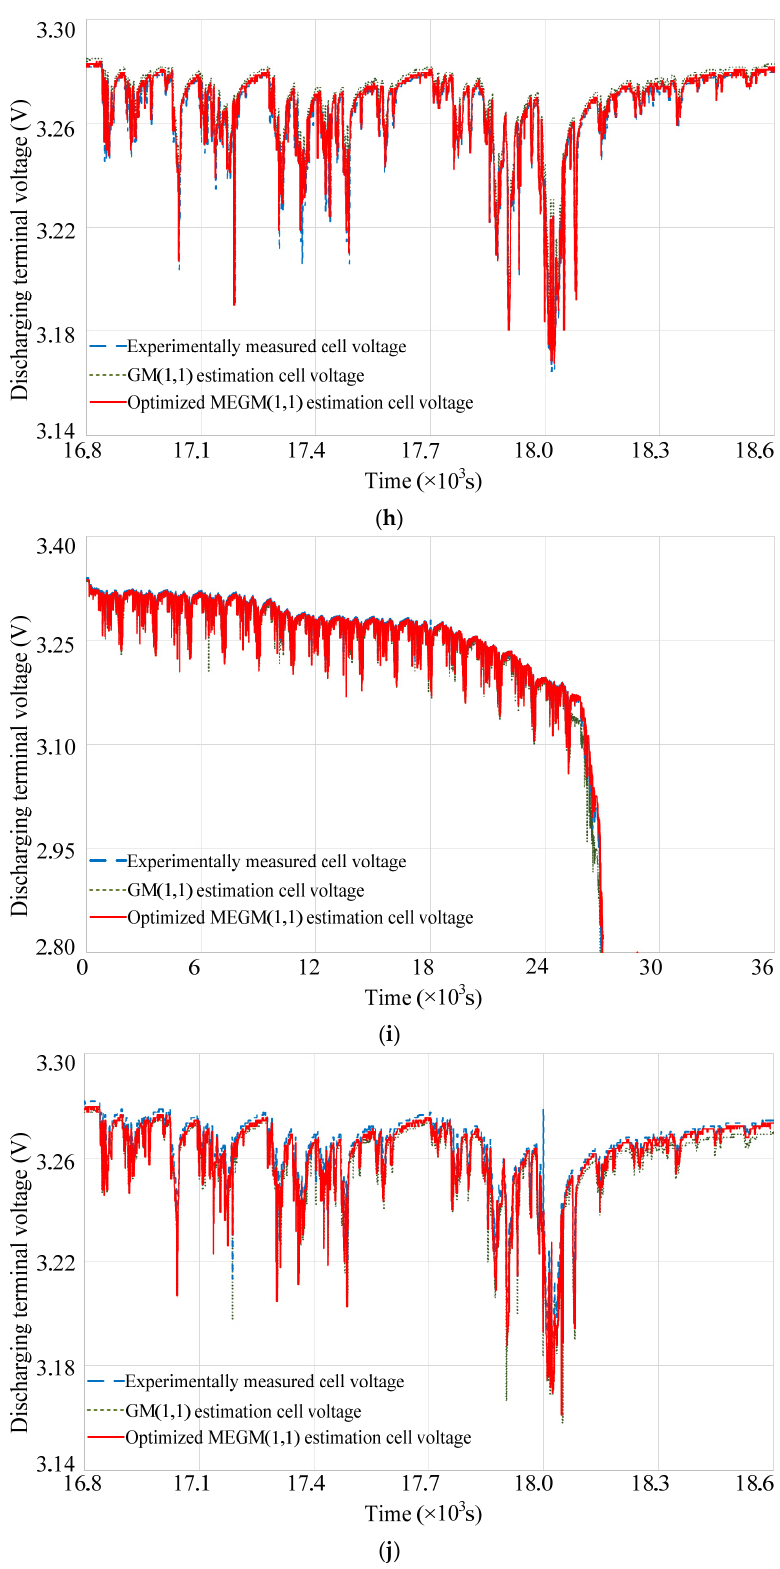
Figure 7. Verification results under the CLTC driving condition at the various temperatures: ( a ) voltage comparison among the measured data, GM(1,1) and MEGM(1,1) estimation at − 10 ◦ C; ( b ) the enlarged view of discharging terminal voltage in one cycle for the time range of 16.8 ks–18.6